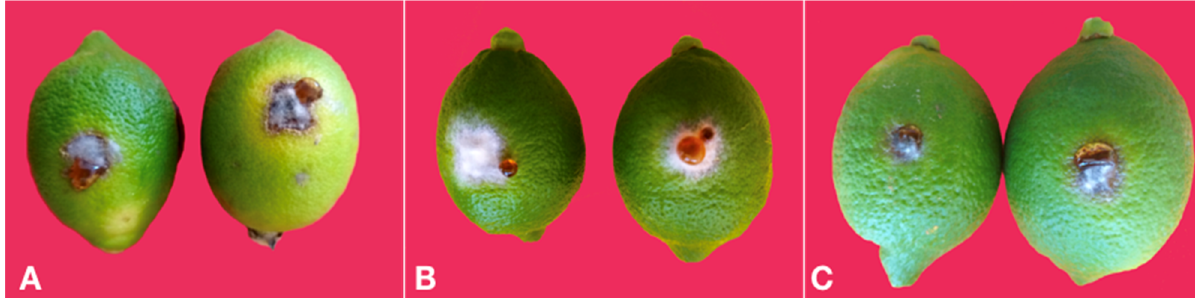
Figure 10. ( A ) Aerial gray mycelium and gum exudate on green fruitlets of lemon ‘Femminello 2Kr’ wound inoculated with an isolate of Colletotrichum gloeosporioides 6 d.p.i. ( B ) Aerial white mycelium and gum exudate on green fruitlets of lemon ‘Femminello 2Kr’ wound inoculated with the reference isolate of Colletotrichum acutatum 6 d.p.i. ( C ) Aerial gray mycelium and gum exudate on green fruitlets of lemon ‘Femminello 2Kr’ wound inoculated with an isolate of Colletotrichum karstii 6